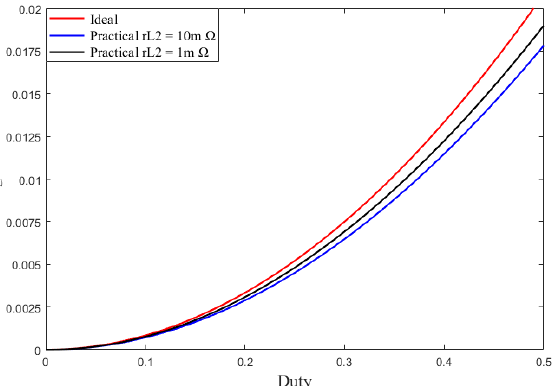
Figure 20. The calculated voltage gain of the proposed topology considering conduction loss.